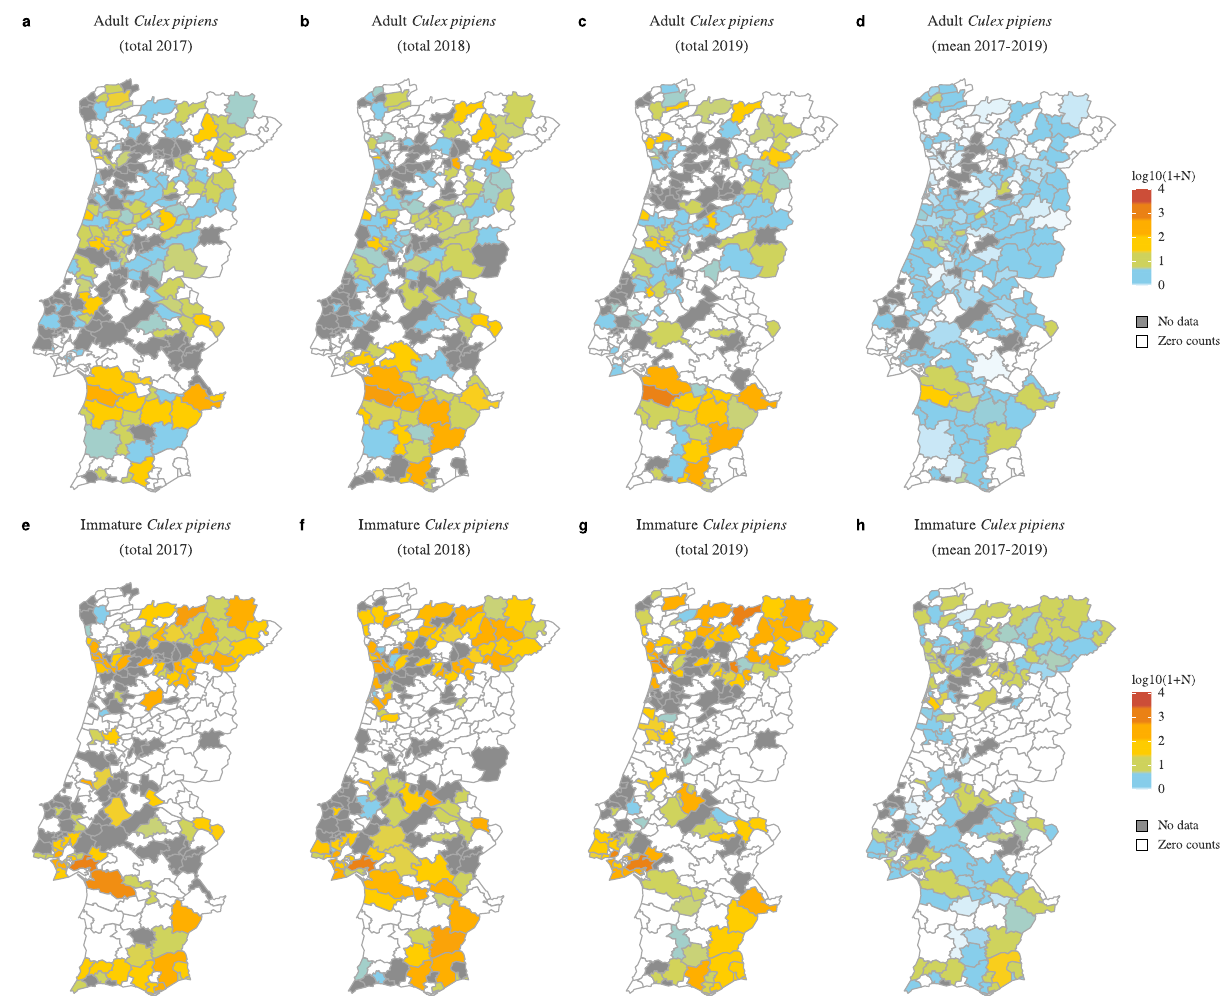
Fig. 2 REVIVE Culex pipiens counts in Portugal (2017 – 2019). Borders represent Portuguese counties, the level at which Cx. pipiens data are reported. a – c and e – g Counties are colored according to the yearly observations (transformed to log 10 ð counts þ 1 Þ ) of adult and immature mosquitoes (respectively). d , h Counties are colored by the yearly mean observations (transformed to log 10 ð mean ð counts Þ þ 1 Þ ) of adult and immature mosquitoes (respectively). Counties for which there were zero counts are coloured in white. Counties for which collections were not performed are in grey.